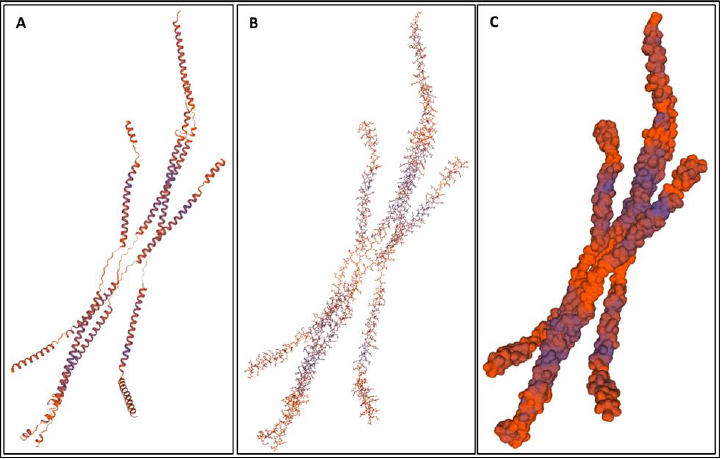
Figure 2. ( A ) A cartoon model, ( B ) a ball-and-stick model, and ( C ) a surface model of GFAP [24].